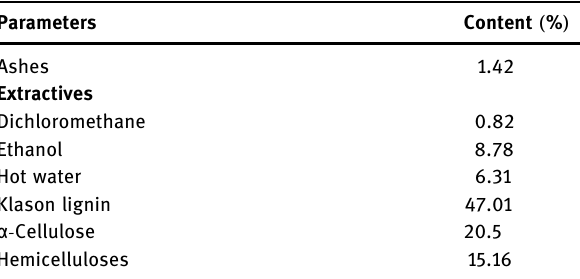
Table 1: Chemical composition of CS ( % dry material )